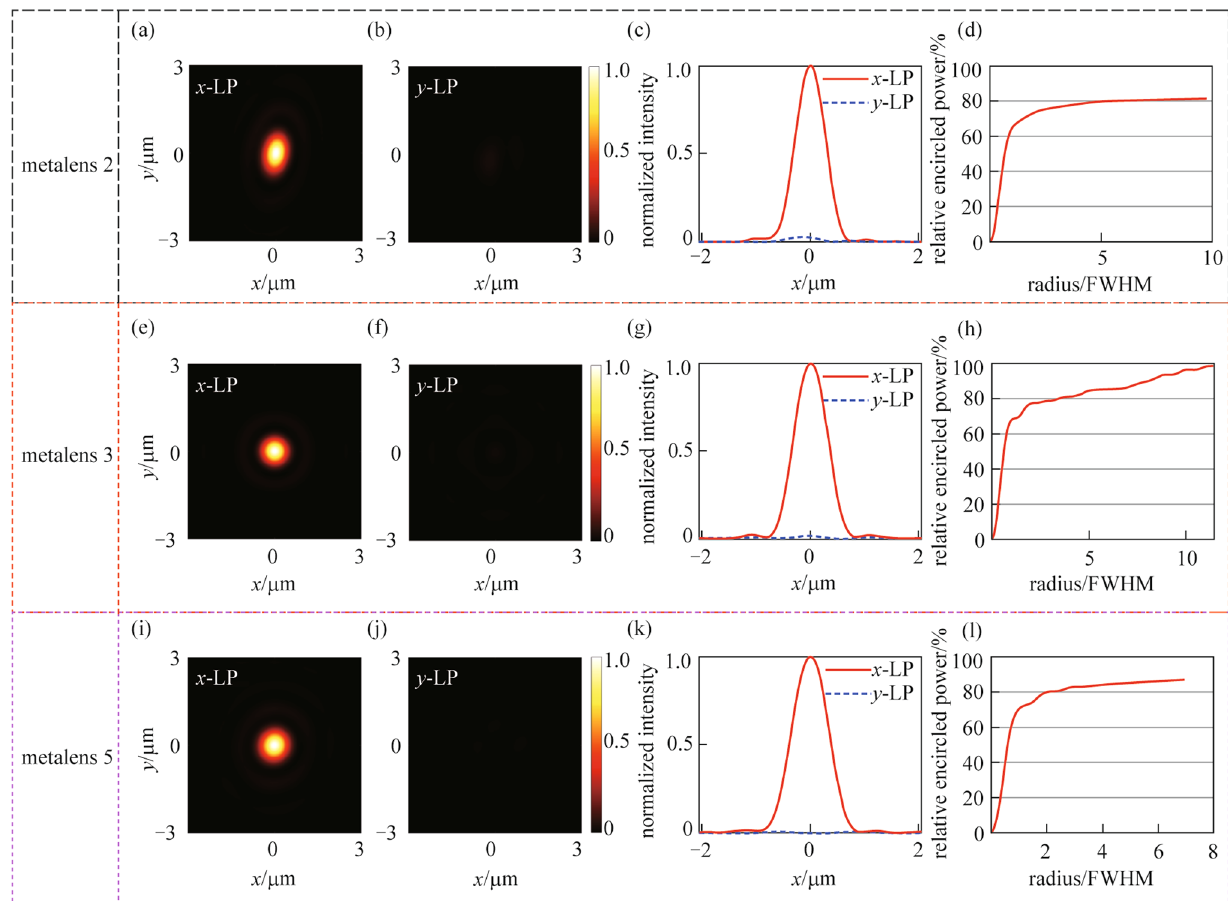
Characterizations of the individual x -LP metalenses 2, 3, and 5. a , e , and i Normalized intensity distributions of the focal plane under the x -LP incidence. b , f , and j Normalized intensity distributions of the focal plane under the y -LP incidence. c , g , and k Normalized intensity distributions along the x -axis. d , h , and l Relative encircled power versus the relative radius of the focal